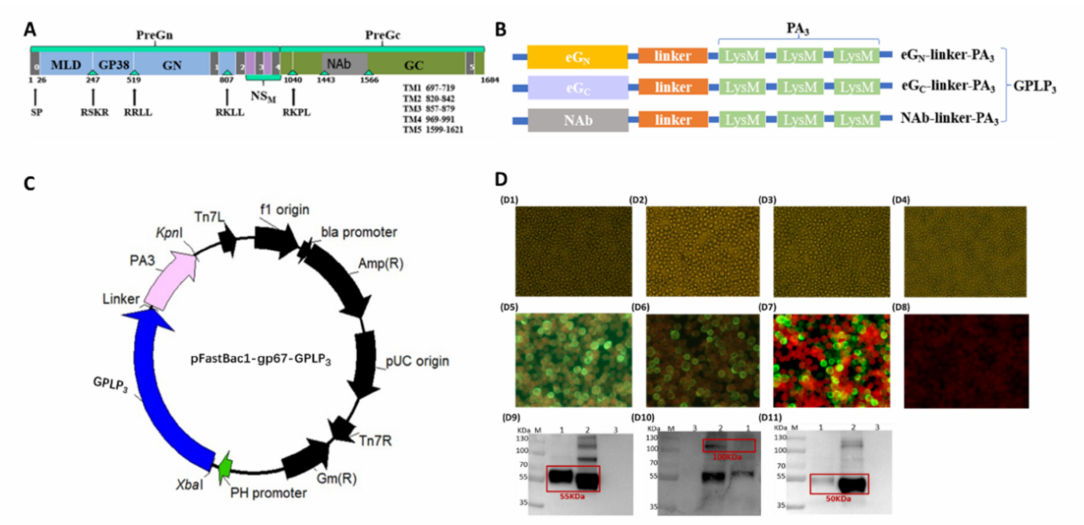
Figure 1. ( A ) Schematic representation of the glycoprotein ORF of CCHFV Ibar10200 strain and construction of the fusion proteins. The precise location of the signal peptide was predicted at aa 1 to 26 by the prediction server Signal P V1.1 (22). TM helix meaning transmembrane helix, and inside meaning the cytoplasmic side, the precise locations of the various regions of glycoprotein ORF predicted by the TMHMM server are as follows: aa 1 to 696 (outside), aa 697 to 719 (TM